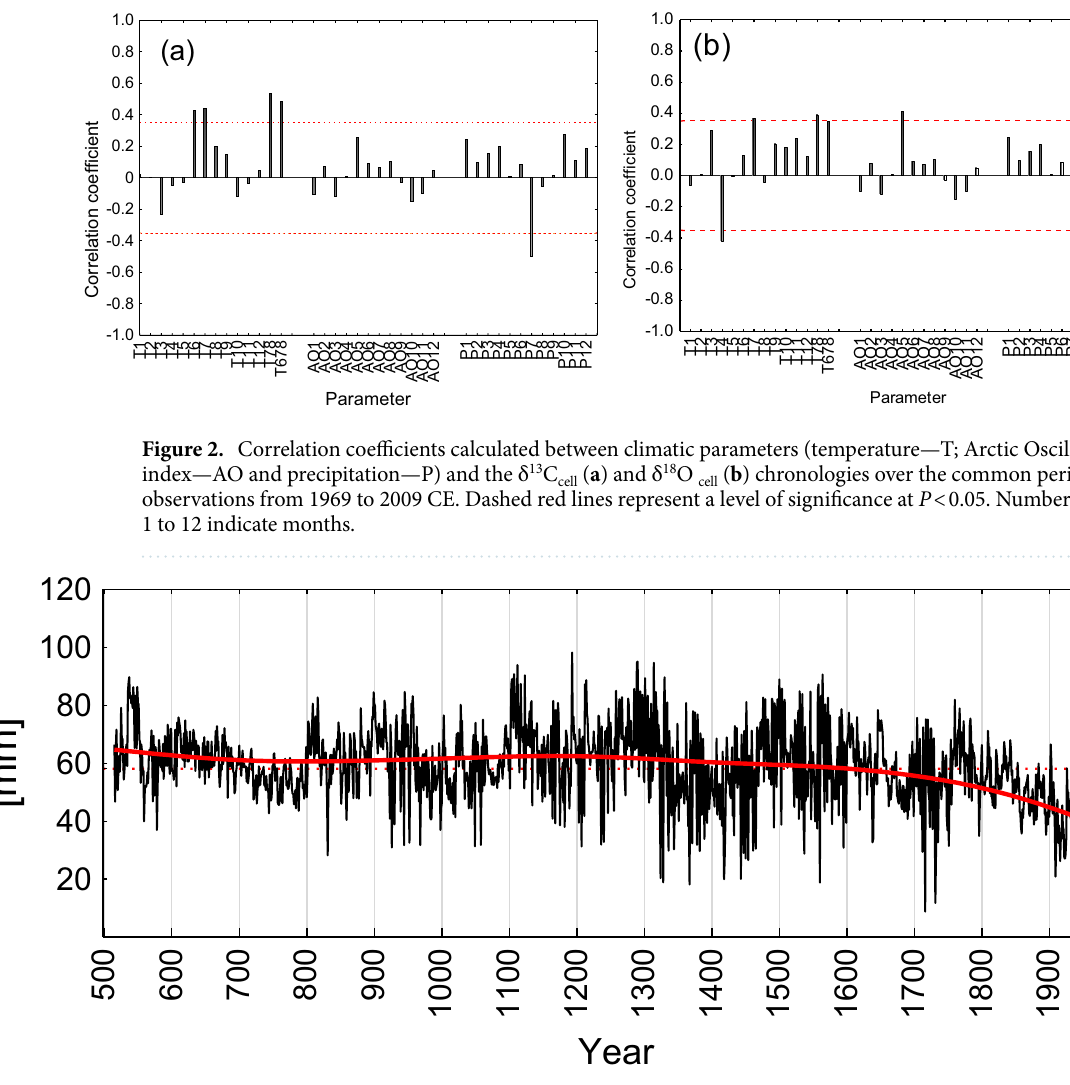
Figure 3. A high-frequency July precipitation reconstruction derived from the δ 13 C cell (black line) and fitted distance weighted LS (bold red line). The standard deviation (SD = 13.39 mm/July, SE = ± 0.35) analyzed for the period 516–2009 CE is represented by the dashed red